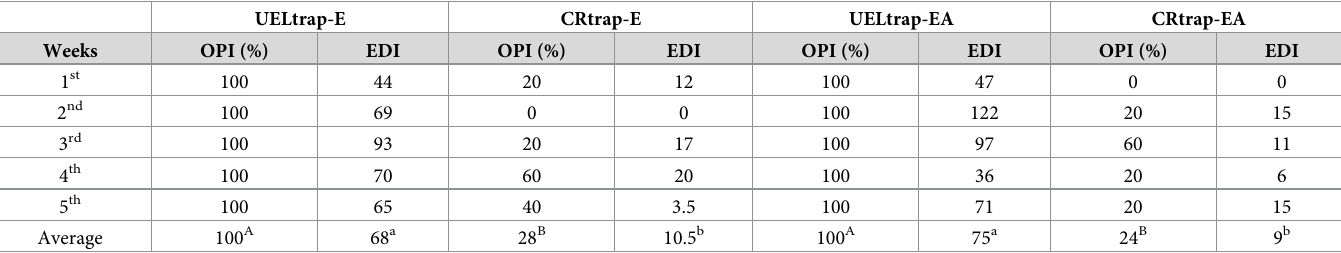
Table 3. Ovitraps positivity index (OPI) and egg density index (EDI) obtained per week in each trap from March to April 2017 in Londrina, Parana´, Brazil.